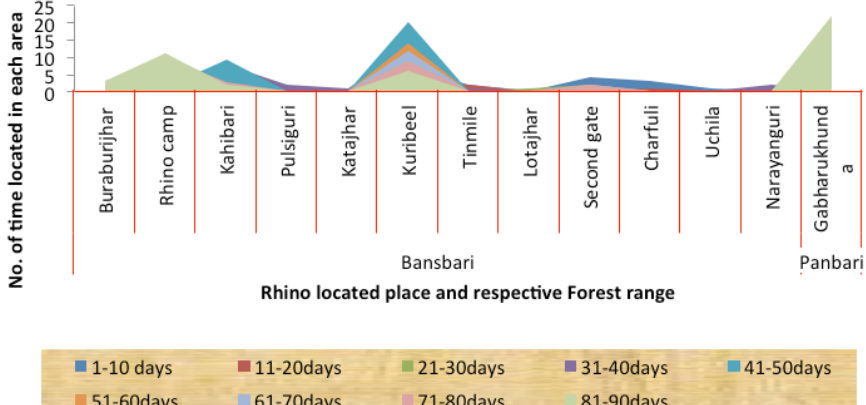
Figure 6. Colonization pattern of the 2 nd group of